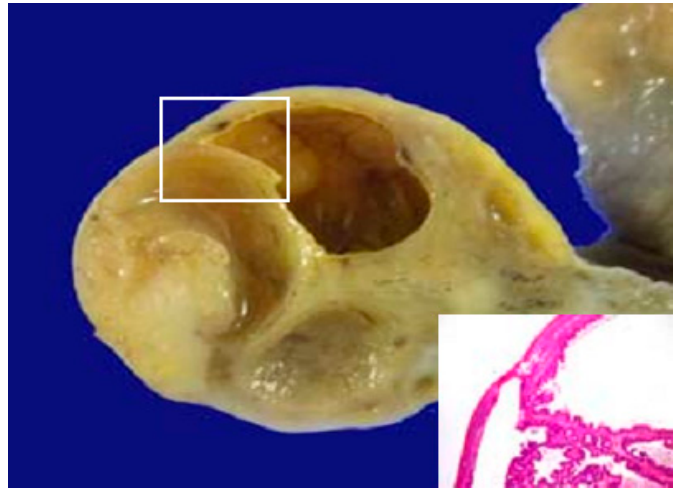
Figure 10. Histological examination revealed metastasis in ovary, which was emitted by ALA PDD.